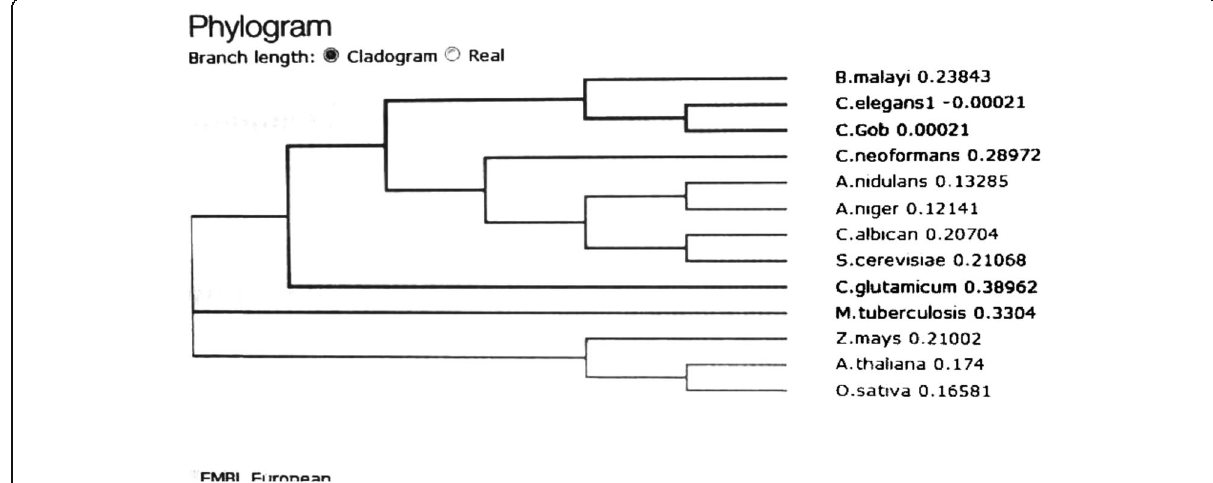
Fig. 2 Phylogram of MSA of various TPP proteins